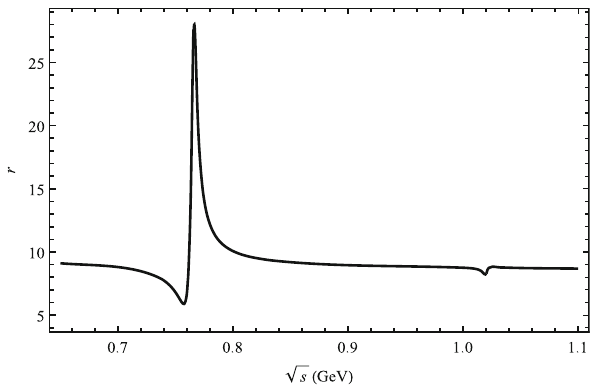
√ Fig. 7 Plot of r as a function of s corresponding to central param- eter values of CKM matrix elements for the decay channel of ¯ B 0 s → π + π − K 0 pair is in the area where the ω resonance is located, then one can find that the sin δ and r vary sharply and sin δ and r vary slightly around the φ resonance range which compared to ¯ → ρ 0 (ω, φ) π 0 → π + π − π 0 B 0 the former. With regard to s process, we obtain the CP asymmetries vary from 65%